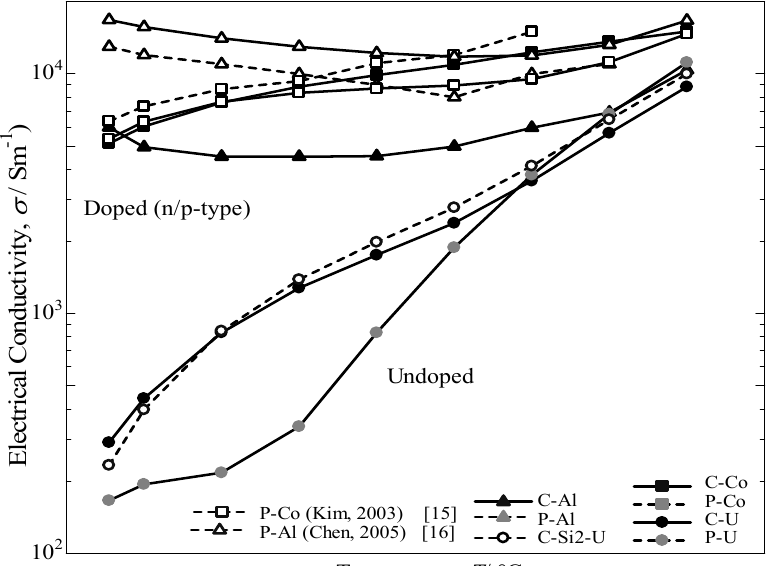
Figure 8. Temperature dependence of electrical conductivity, σ , for the annealed β -FeSi samples at 900 °C for 5